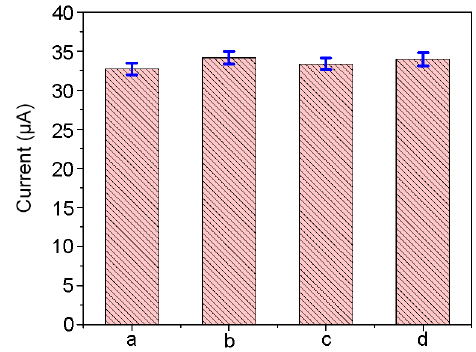
Figure 7. Results obtained using the CA242 immunosensor are highly sensitive and reproducible. Statistics for current responses obtained from five parallel experiments using 5 U/mL CA242 in pure human serum ( a ) and with 0.15 mM ascorbic acid ( b ), 0.5 mM uric acid ( c ), or 0.15 mM dopamine ( d ).